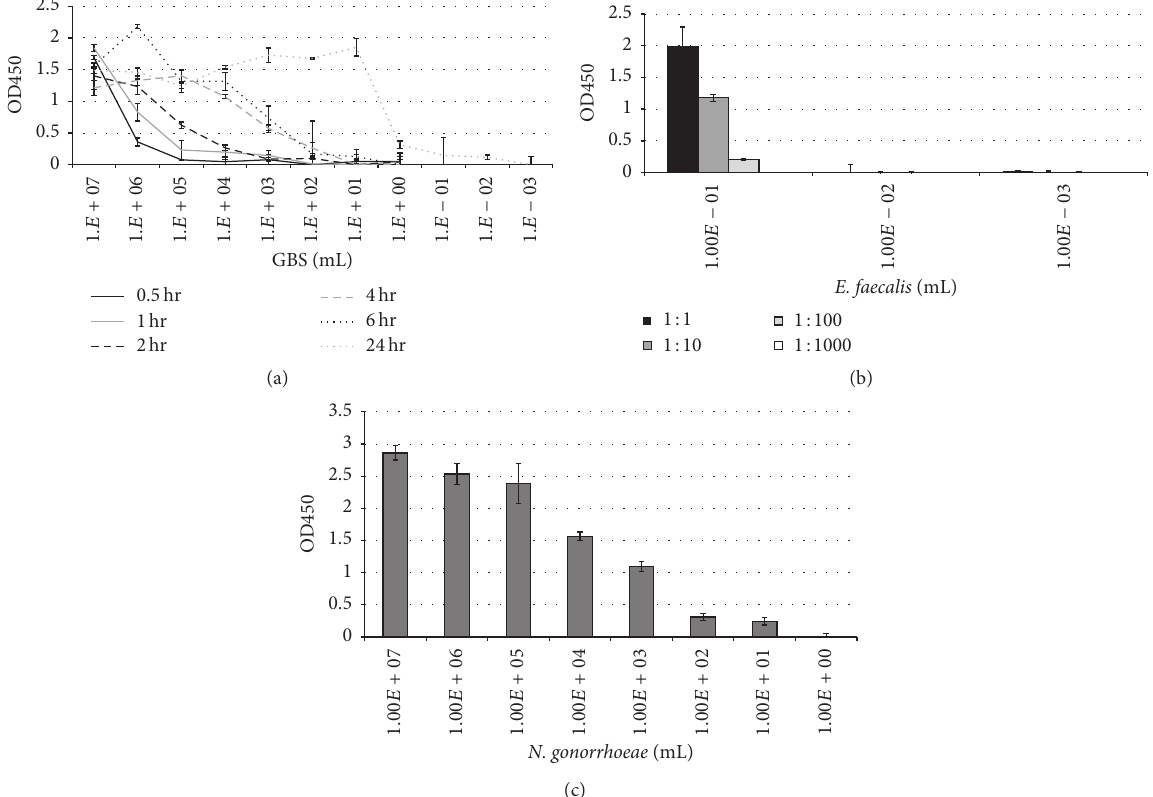
Figure 2: Determination of the limit of detection following incubation at 37 ∘ Celsius. GBS (a), Enterococcus (b), and N. gonorrhoeae (c) were prepared at 0.5 McFarland in Fastidious Broth and diluted out serially. For GBS, samples were incubated for either 0.5, 1, 2, 4, 6 or 24 hours at 37 ∘ Celsius (a). For E. faecalis , samples were incubated overnight at 37 ∘ Celsius. Tubes were noted to be turbid down to 10 0 bacteria per mL, and this sample and the following two dilutions, 10 −1 and 10 −2 bacteria per mL, were prepared further by diluting in PBS out to 1: 1,000. For N. gonorrhoeae , samples were prepared at a 0.5 McFarland in Fastidious Broth and then incubated overnight at 37 ∘ Celsius (c). Following these incubation time-points for each study, 10 𝜇 L of each sample was transferred to microtiter wells containing 90 𝜇 L PBS and allowed to stand for 20 minutes at room temperature. Any bound organism was detected by HRP-conjugated antibody against the specific pathogen. As with Figure 1, three distinct strains of GBS were tested, as were two strains of Enterococcus and N. gonorrhoeae each. Results shown are of GBS clinical isolate 01.12.76 (a), Enterococcus ATCC strain 29212 (b), and N. gonorrhoeae strain 19424 (c), each performed in triplicate and representative of three individual experiments. Again, bacterial concentrations were confirmed by CFUs following plating on agar for 24–48